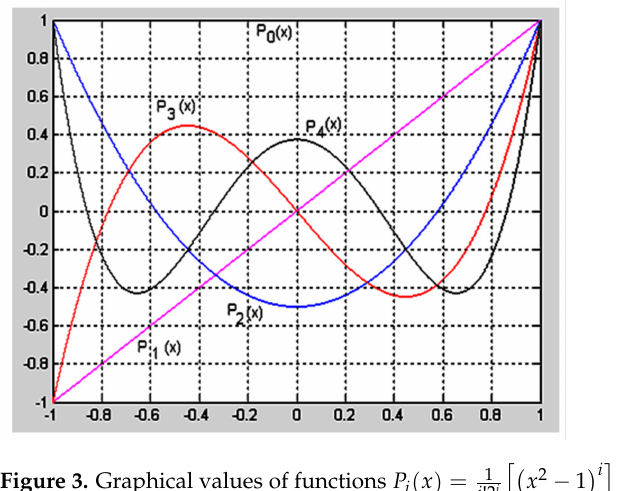
Figure 3. Graphical values of functions P i ( x ) = 1